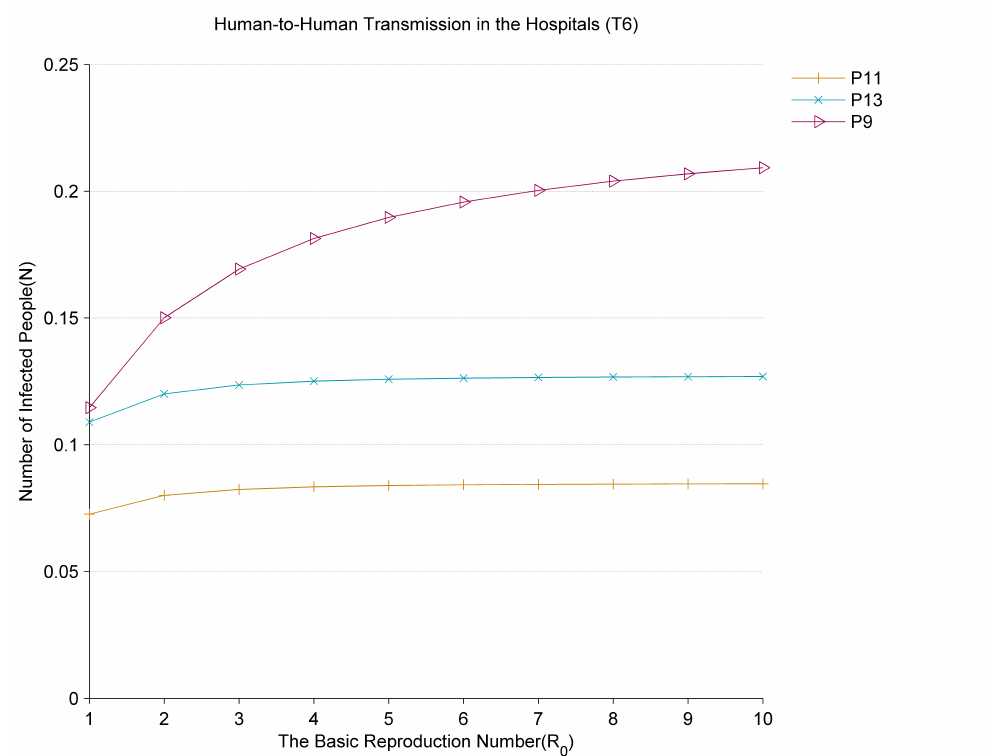
Figure 5. Relationship between the basic reproduction number ( R 0 ) and the number of infected people in the hospitals.